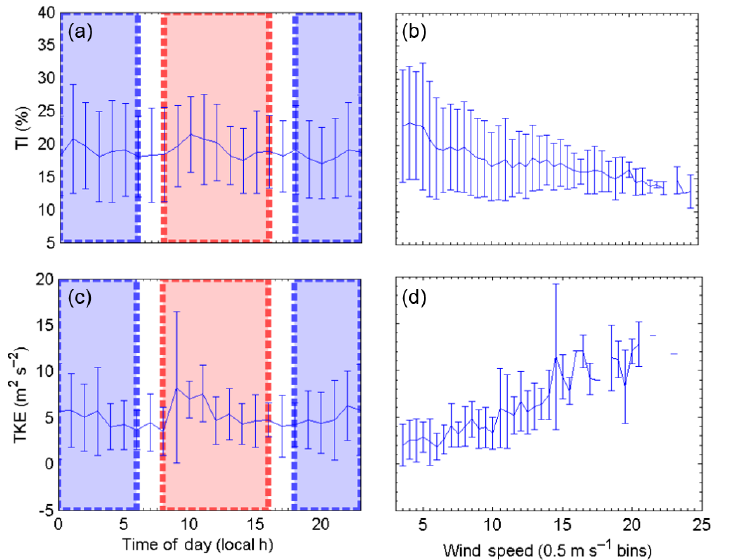
Figure 12. TI (a) and TKE (c) calculated with near-hub-height tower measurements vs. time of day, where hour 0 and hour 24 represent local midnight. The blue line represents the mean TI in the corresponding hour and the error bar represents the standard deviation. The blue rectangle represents nighttime hours and the red rectangle represents daytime hours. Mean and standard deviation of TI (b) and TKE (d) calculated with near-hub-height tower measurements in each wind speed bin. Includes data filtered for tower 80m wind speeds between 3.5 and 25.0ms − 1 , 87m wind directions between 235 and 315 ◦ , and for normal turbine